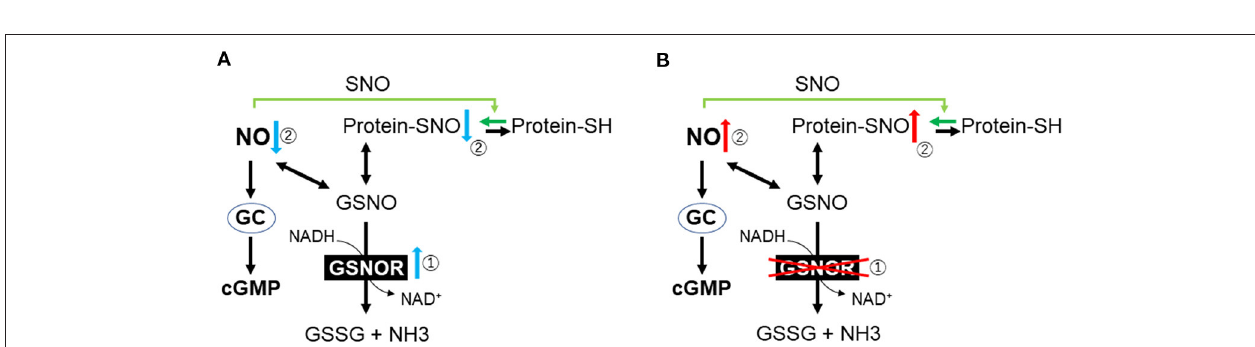
FIGURE 2 | Outline of nitric oxide metabolism. (A) Cardiac arrest and resuscitation increase the activity of GSNOR. (B) Genetic or pharmacological inhibition of GSNOR increases the tissue levels of protein SNO and NO bioavailability. GC, guanylyl cyclase; cGMP, cyclic guanosine monophosphate; SH, cysteine thiols; GSNO, S-nitrosoglutathione; GSNOR, GSNO reductase; GSSG, glutathione disulfide; NH3, ammonia; NO, nitric oxide; SNO, S-nitrosylation.